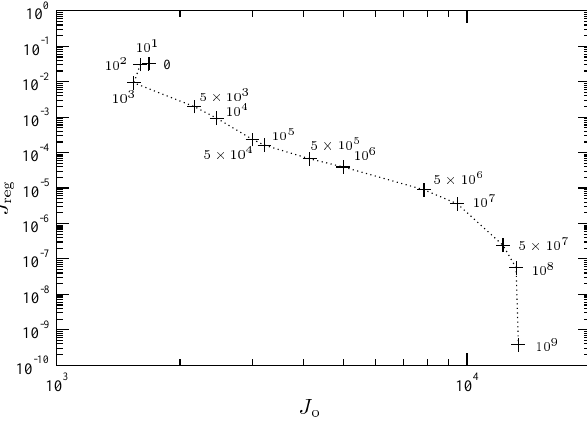
Fig. 3. Log-log plot of the norm of the regularised solution J reg given by Eq. (13) versus the norm of the initial cost function J o given by Eq. (9), the so-called L-curve. The cross correspond to the regularisation parameters from λ =0 up to λ =10 9 .